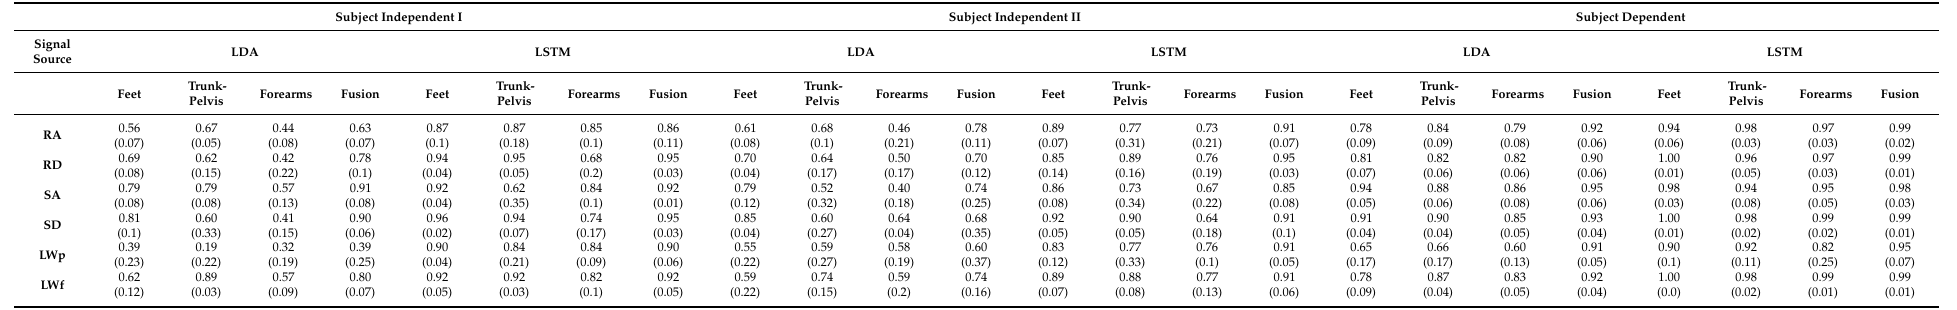
Table 1. F1 scores for classification of target locomotor tasks using signals from varying body segments and across different classification algorithms and training paradigms. values in the parenthesis are standard deviations.